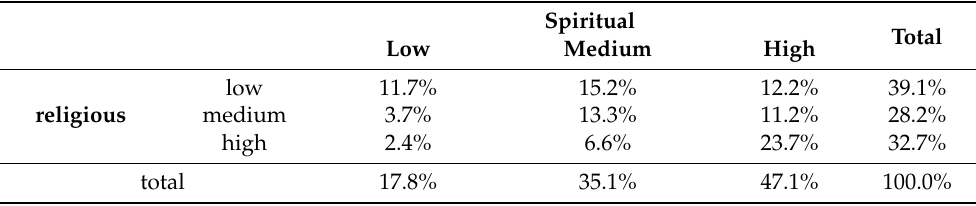
Table 8. Cross-tabulation of low, medium, and high expression of religious and spiritual self-concept among German-speaking pilgrims in percent ( N =